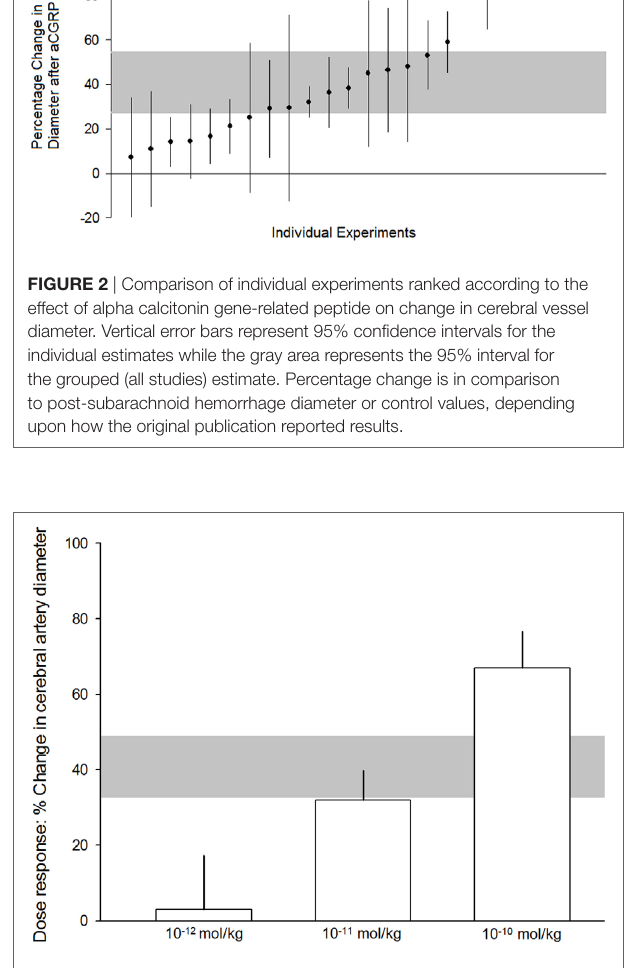
FiGURe 3 | Dose–response relationship. 10 − 12 mol/kg of alpha calcitonin gene-related peptide ( α CGRP), 3.1 ± 14.2%. 10 − 11 mol/kg α CGRP, 32 ± 7.8%. 10 − 10 mol/kg α CGRP, 67 ± 9.7%. The error bars represent SE while the shaded gray area represents the SE of the grouped (all experiments with single doses) estimate. Differences were statistically significant ( p < 0.05).